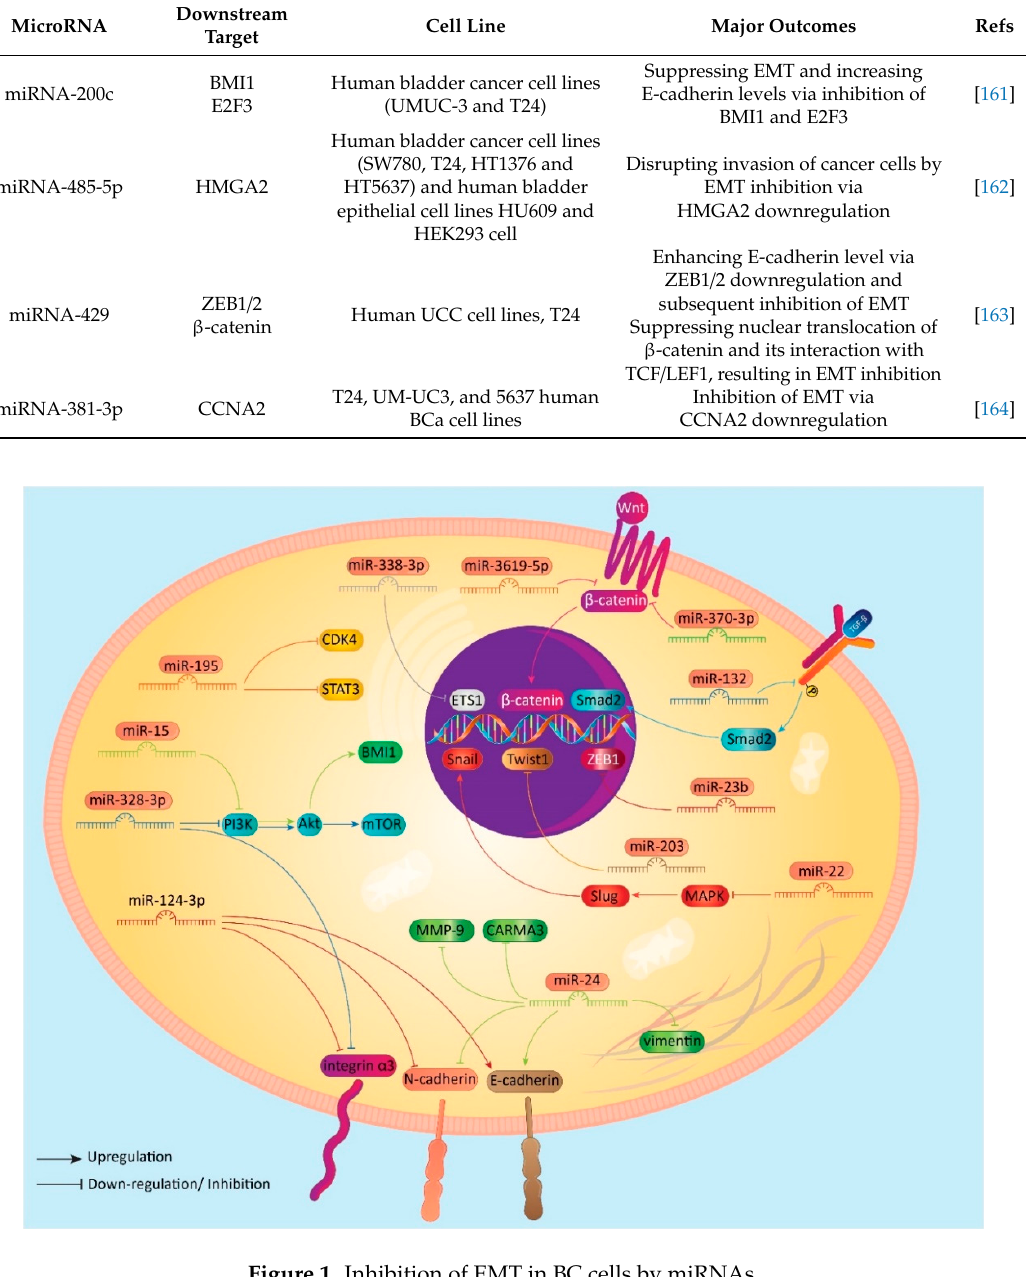
Figure 1. Inhibition of EMT in BC cells by miRNAs. Table 1. MicroRNAs inhibit EMT in BC cells.